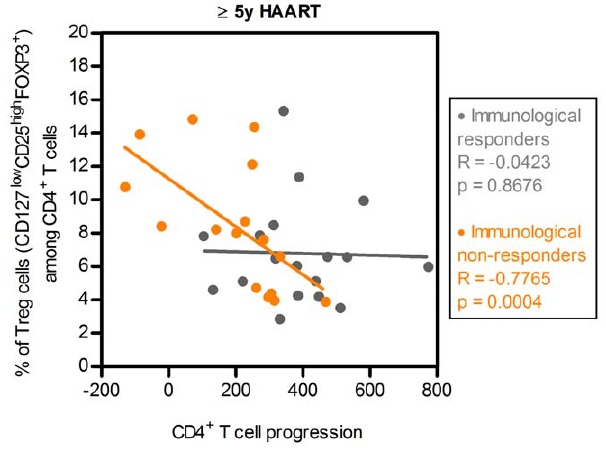
Figure 4. Immunological non-responders present a strong correlation between Tregs percentages and CD4 + T cell progression. Scatter plot illustrating the correlation between Tregs percentages and CD4 + T cell progression. Patients were selected on the basis of being under HAART for at least 5 years and whose actual CD4 + T cell counts are , 500 cells/ m L or . 500 cells/ m L. Each dot represents a single individual.